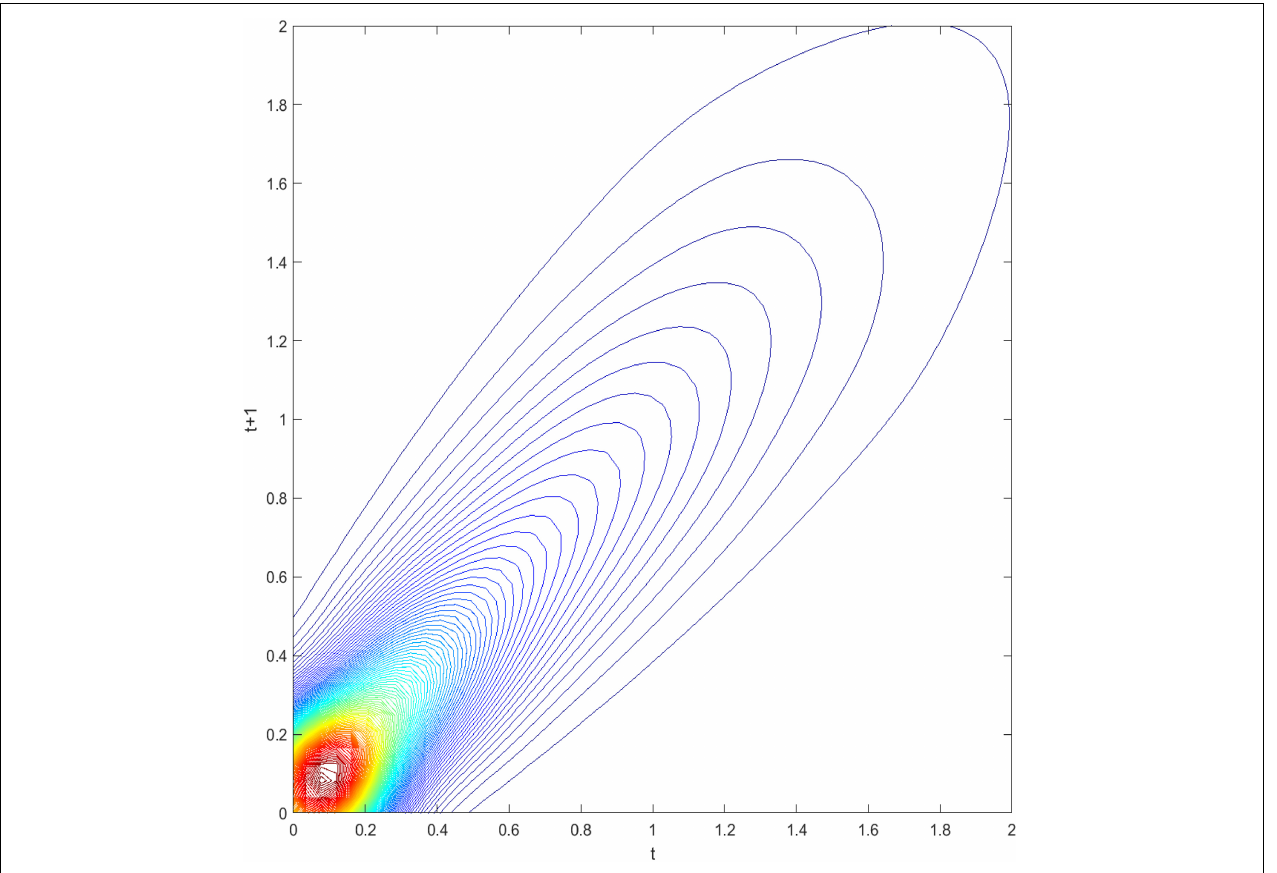
FIGURE 4 | Contour map of transition probability kernel for the RSVAPC of all countries with annual transitions. Source: Authors’